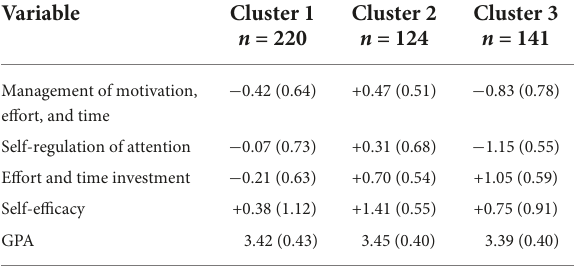
TABLE 3 Mean (M) and standard deviation (in parentheses) of clusters of